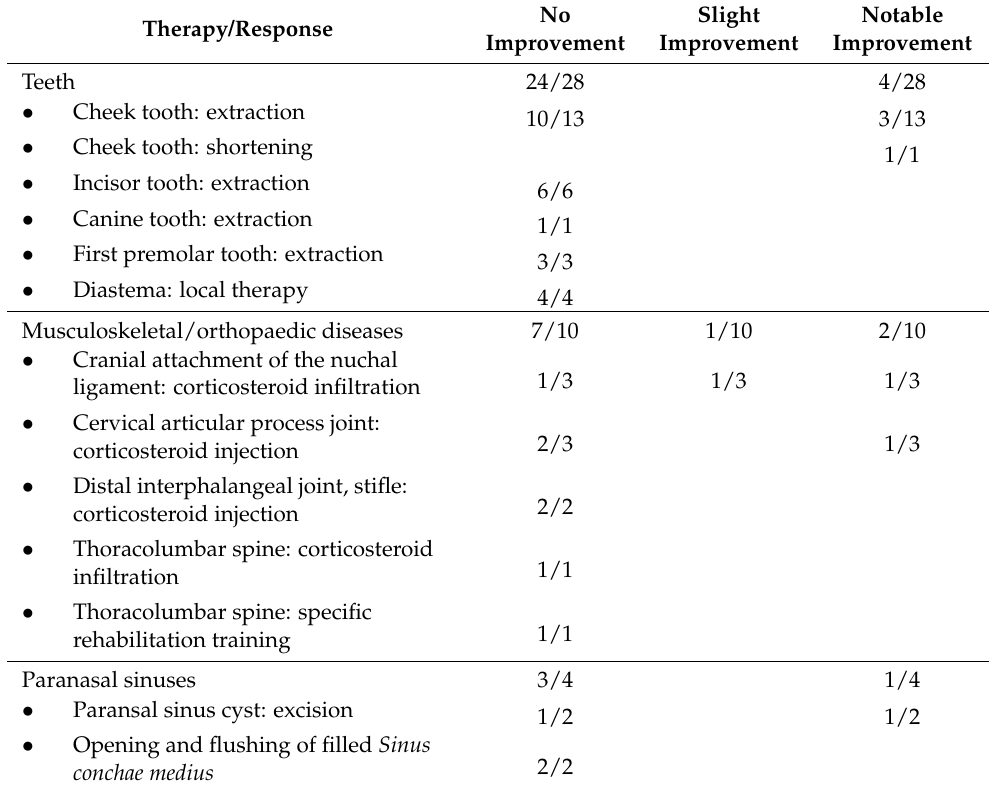
Table 4. Success of conducted targeted therapies of findings within the diagnostic investigation